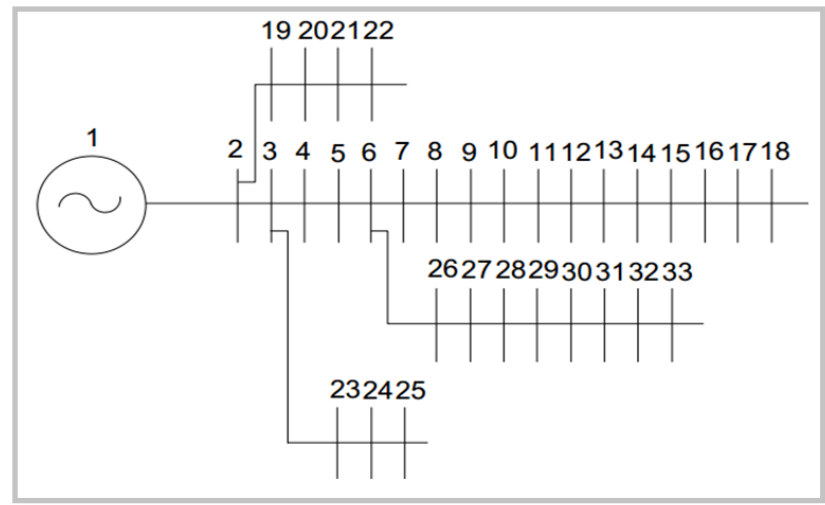
Figure 2. 33-base distribution network schematic. Table 1. Technical-economic data on wind turbines, electric parking, and network.